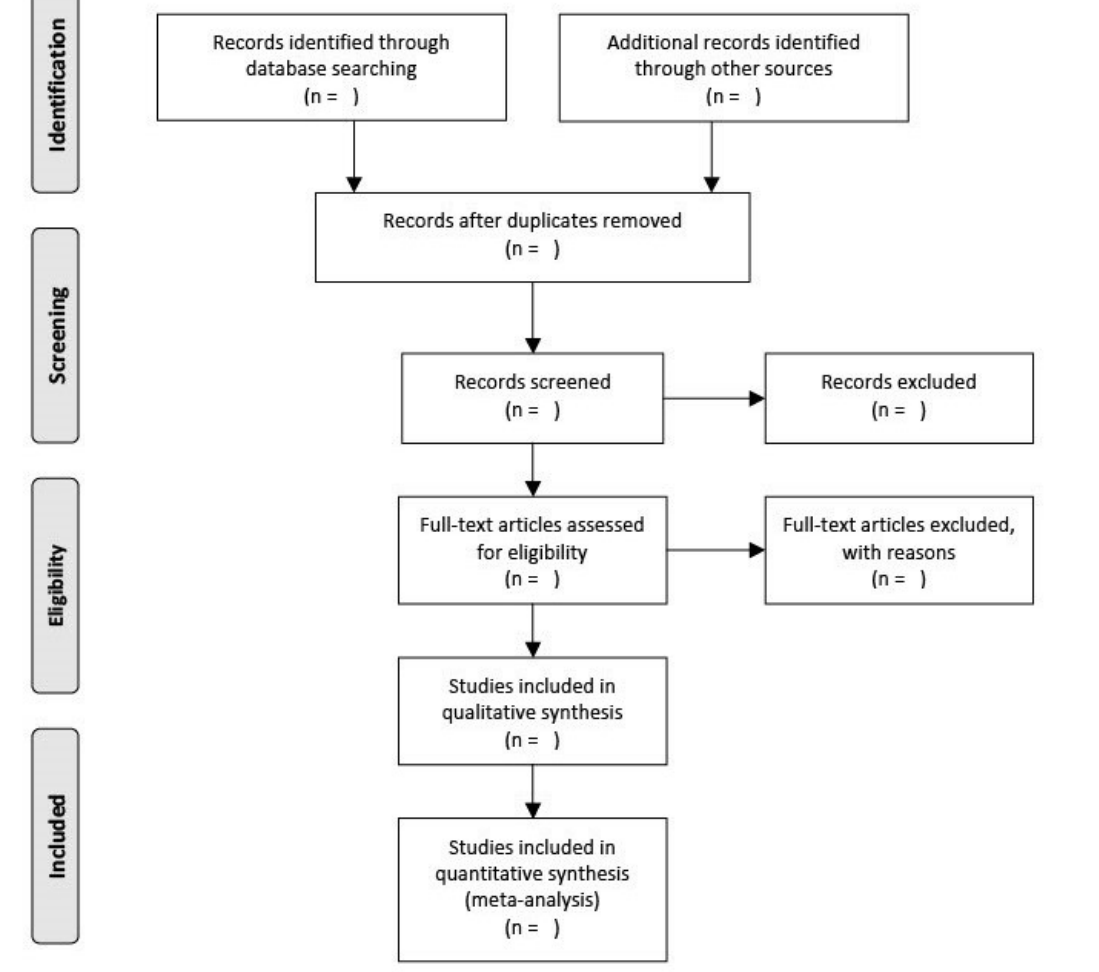
Figure 1. PRISMA [29] flow diagram of the selection process that will be